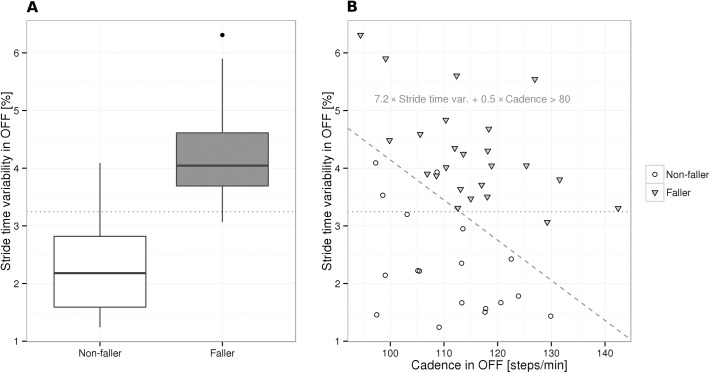
Comparison of PD fallers and non-fallers based on logistic regression models.A: PD fallers exhibited higher stride time variability compared with non-fallers. The dotted line shows the optimal logistic regression classification threshold of 3.25%. B: The multiple logistic regression model predicted fallers as patients having 7.2 × stride time variability in the OFF state + 0.5 × cadence in the OFF state greater than 80 (corresponding to the area above the dashed line). The dotted line shown in A is overlaid for visual comparison.